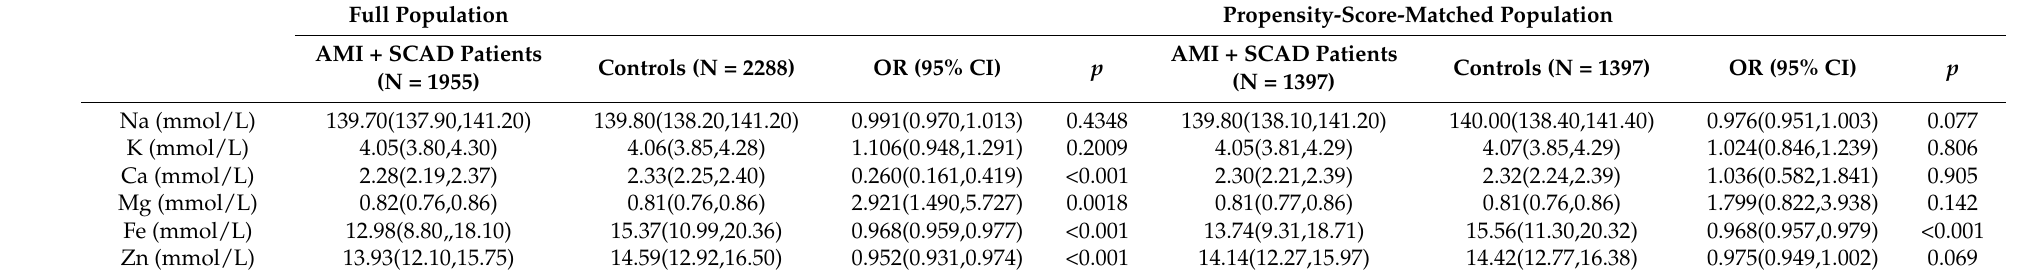
Table 6. Association between the levels of metals and AMI + SCAD—controls risk in the multivariable logistic regression